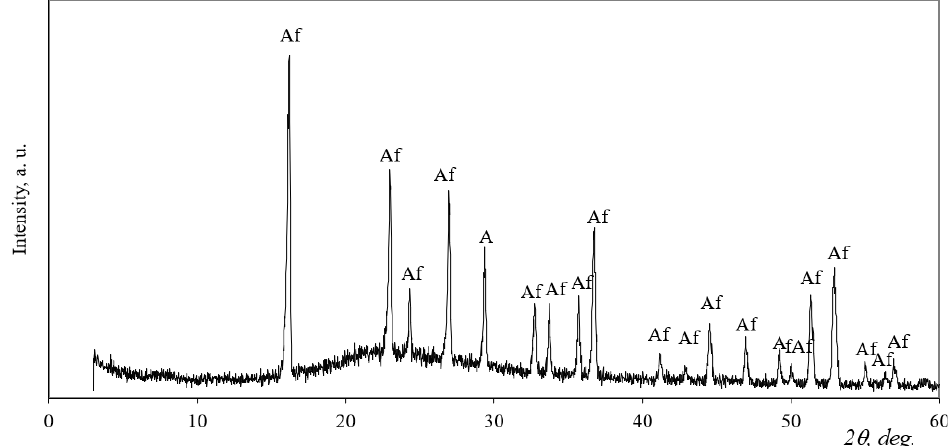
Fig. 3. The X-ray diffraction pattern of silica gel. Af – (PDF-2 # 35-827) aluminium fluoride hydrate (AlF 3 ·3.5H 2 O). The DTA/TG analysis of raw clay is given in Fig. 4.